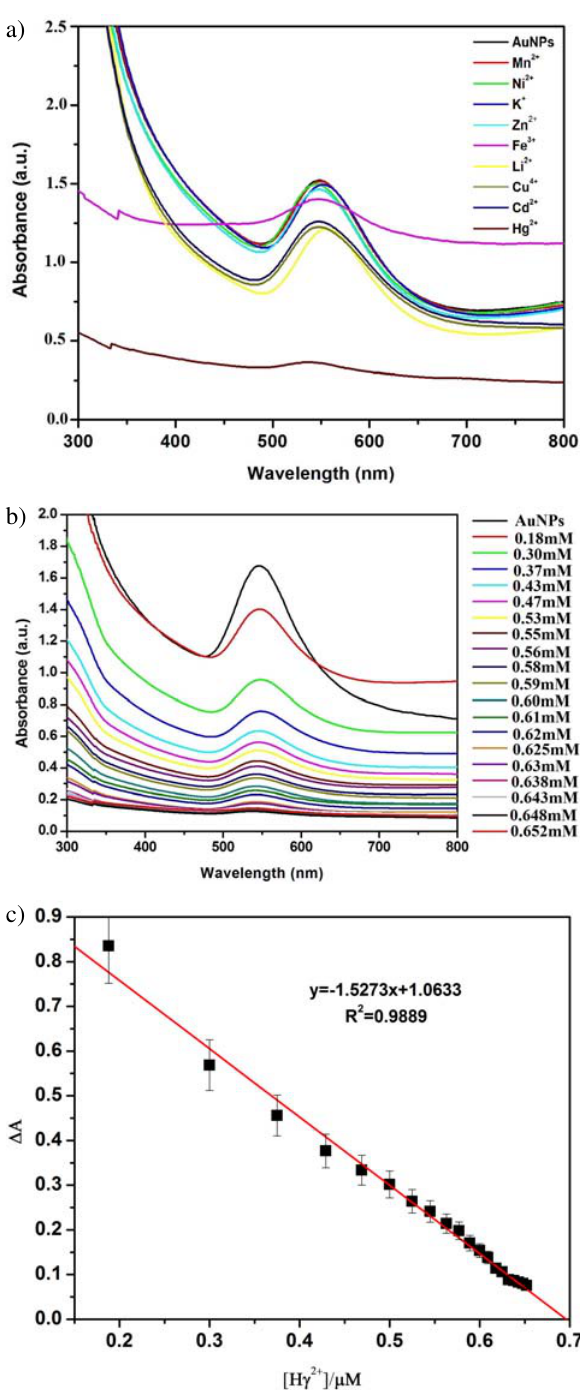
Figure. 7. (a) UV-vis absorption spectrum and photographs (inset) of AuNPs with different heavy metal ions, (b) UV-vis absorption spectrum of AuNPs solution upon addition of Hg 2+ ions (0.188 mM to 0.653mM) and (c) plot of absorbance ( Δ A) intensity at 544 nm versus Hg 2+ ions